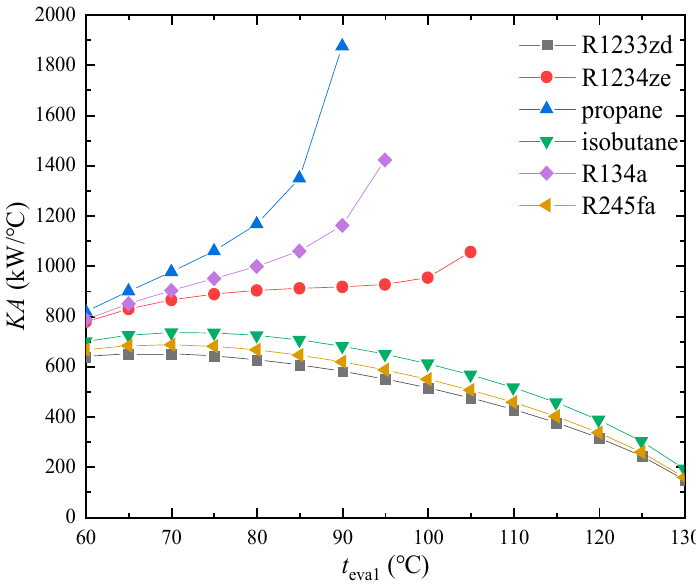
Figure 4. Thermal conductance for the geothermal fluid temperature of 140 °C.